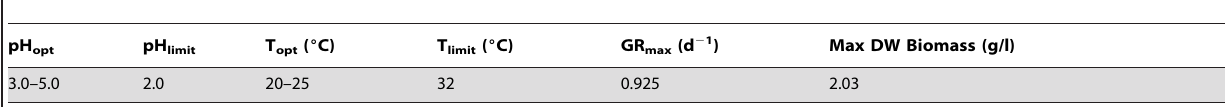
Table 1. Physiolohical features of strain